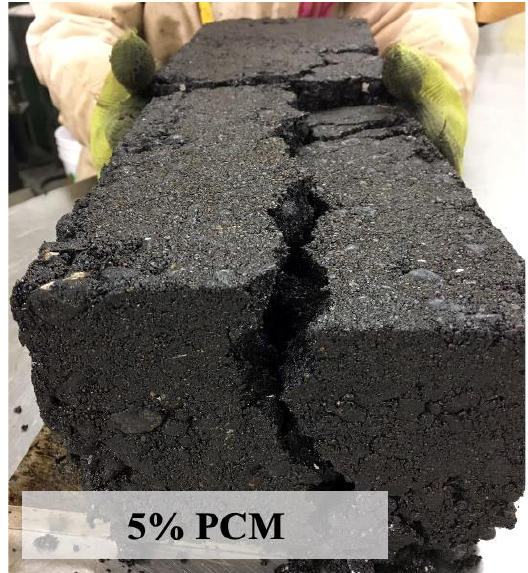
Figure 4. Asphalt specimen containing 5%PCM mixed/compacted at high temperature.